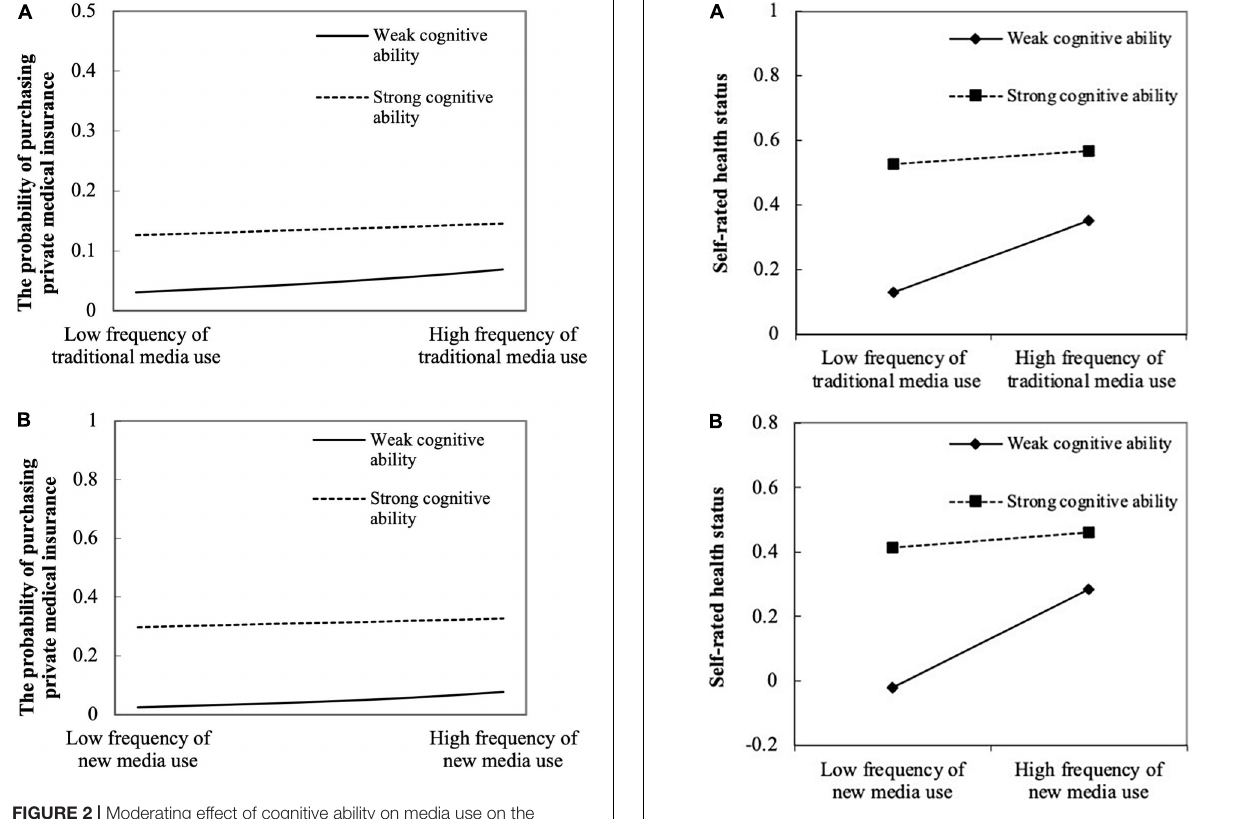
consistent with the previous ones after excluding people over